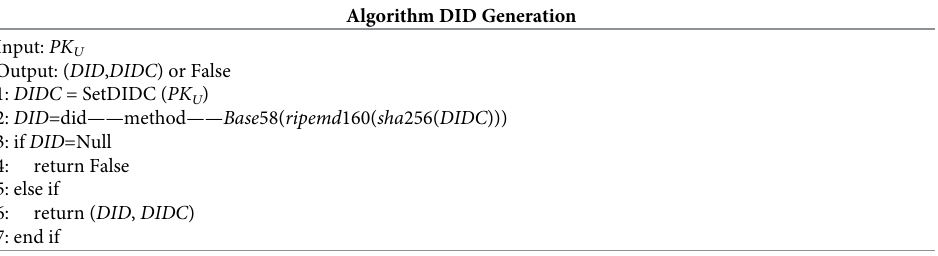
Table 3. DID generation